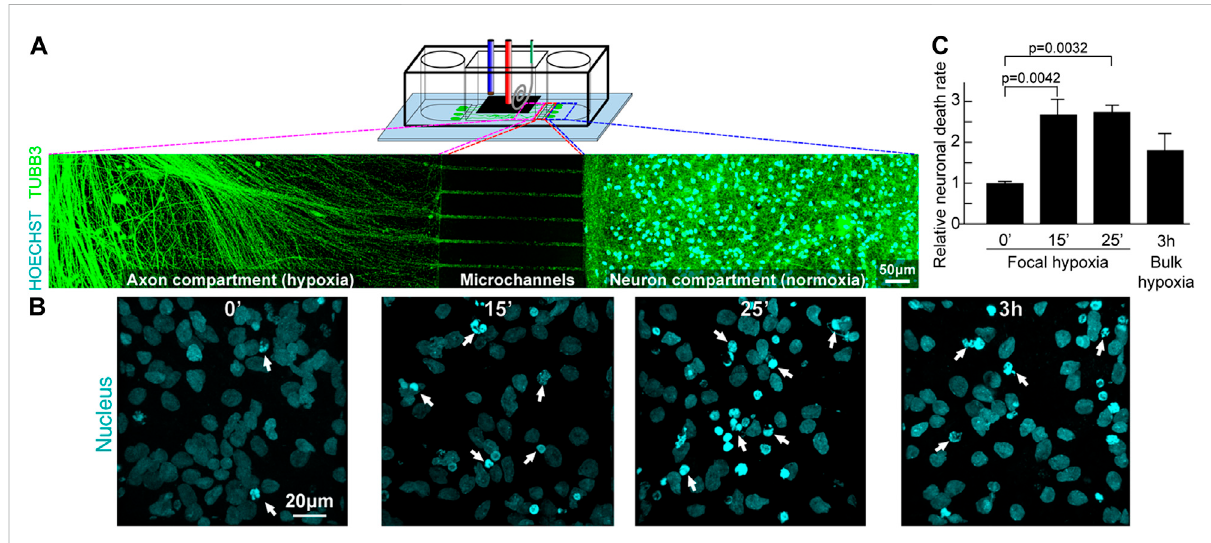
FIGURE 10 Focal hypoxia in a human cortical neuron microchannel model. (A) Schematic presentation of the microchannel model. Representative confocal tile image of neurons growing across the microchannels. Cyan: cell nucleus; green: axons. (B) Representative confocal image of cell nucleus (cyan) at the end chambers and axons in the central chamber after hypoxic insults. (C) Quantitative analysis of cells with chromatin condensation ( n =